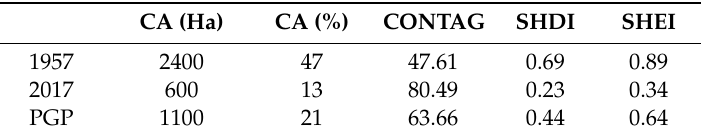
Table 5. Optimizing landscape configuration to enhance non-forest habitat suitability using PGP (Patch-Growing